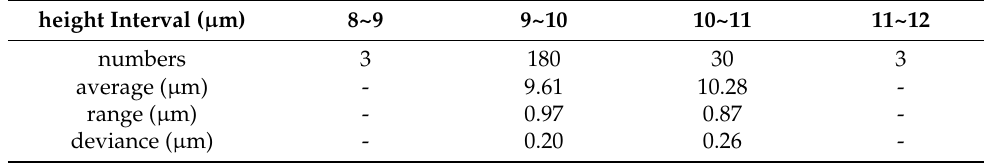
Table 3. Au bump height statistical